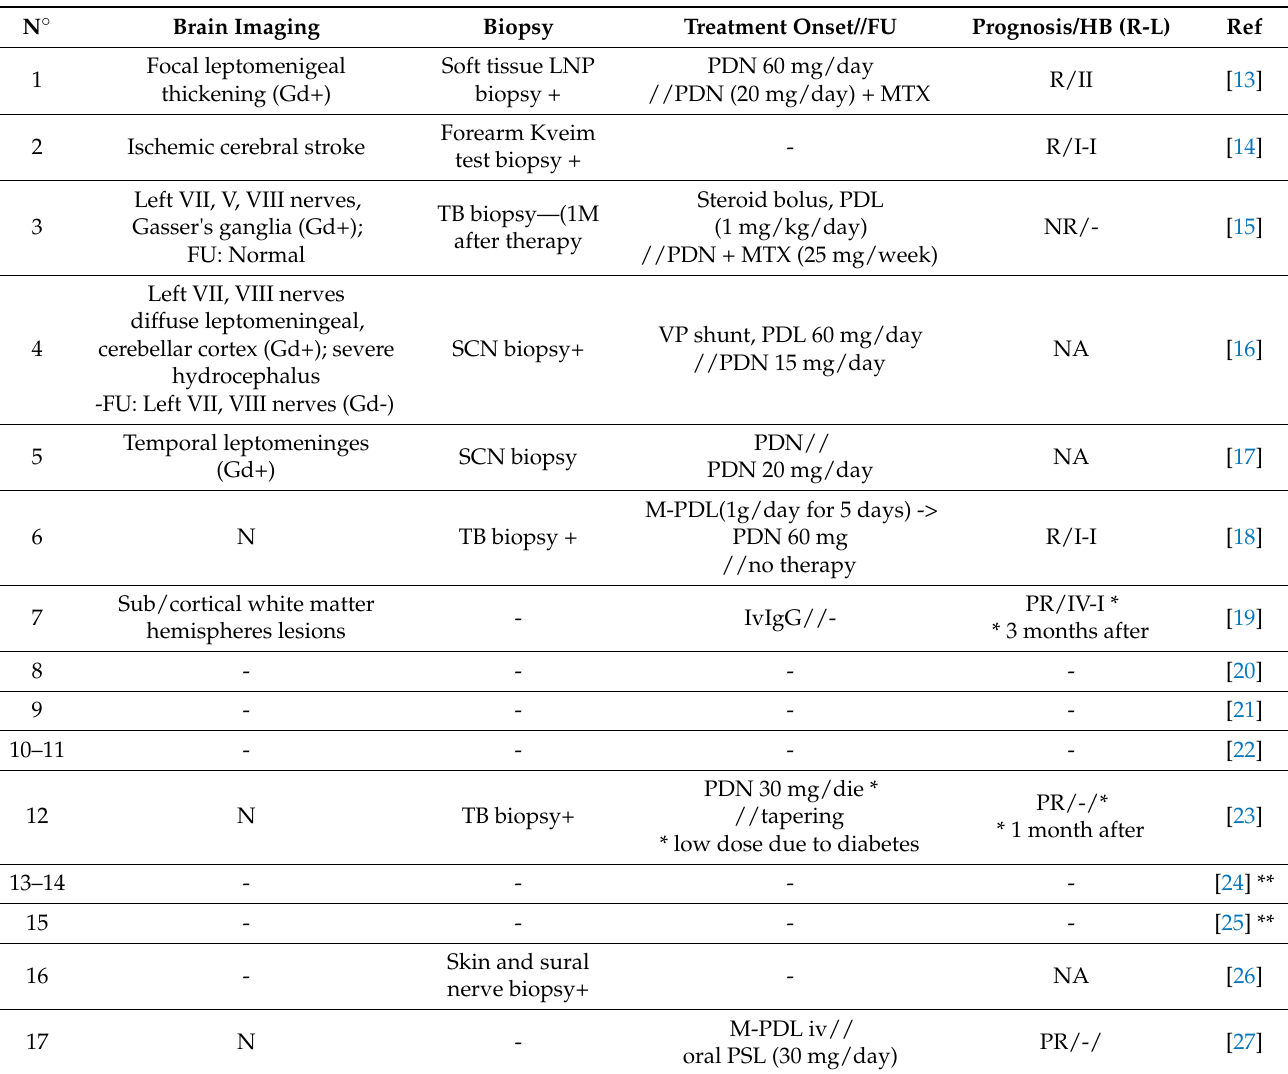
Table 2. Demographic and clinical properties of patients with bilateral facial palsy/plegia as the onset of NS (Heerfordt’s syndrome cases not